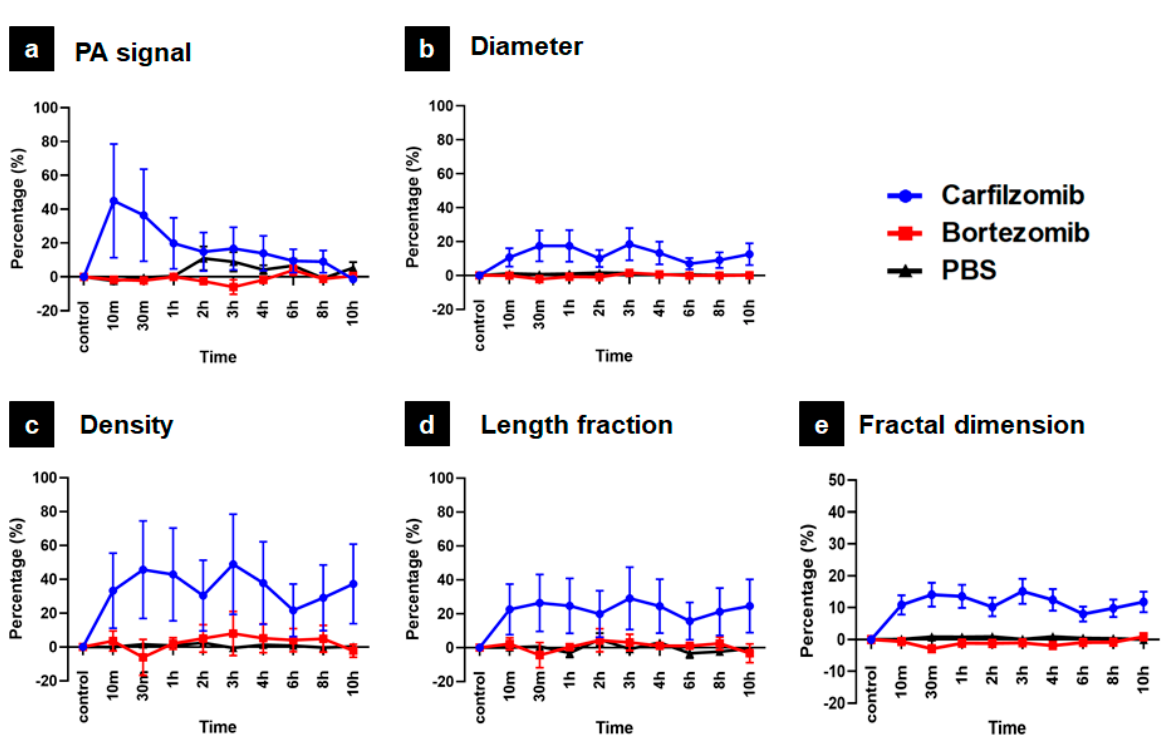
Figure 6. Quantitative evaluation results among carfilzomib, bortezomib, and PBS. ( a ) PA signal, ( b ) Diameter, ( c ) Density, ( d ) Fraction length, ( e ) Fractal dimension.